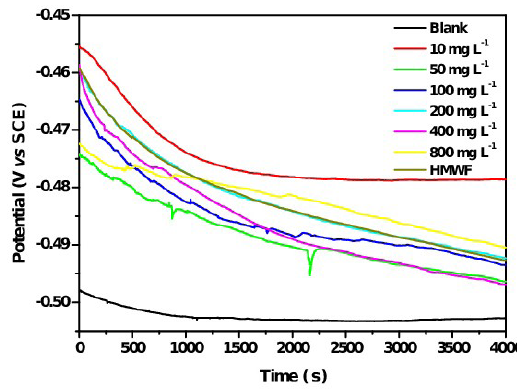
Figure 2. OCP plots of mild steel in 1 mol L −1 HCl at different concentrations of ACSE and at 400 mg L −1 of Table 3. Thermodynamic activation functions of the corrosion processin the absence and presence of ACSE. E (kJ mol -1 ) a